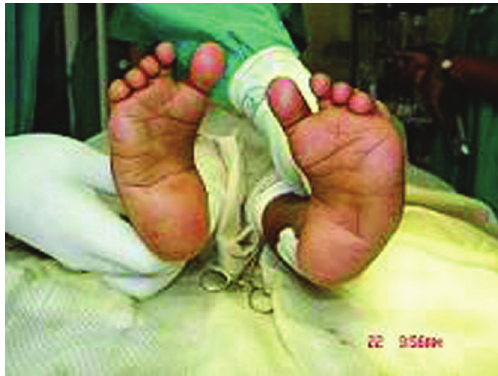
Figure 1: Clinical photo showing deformities in both